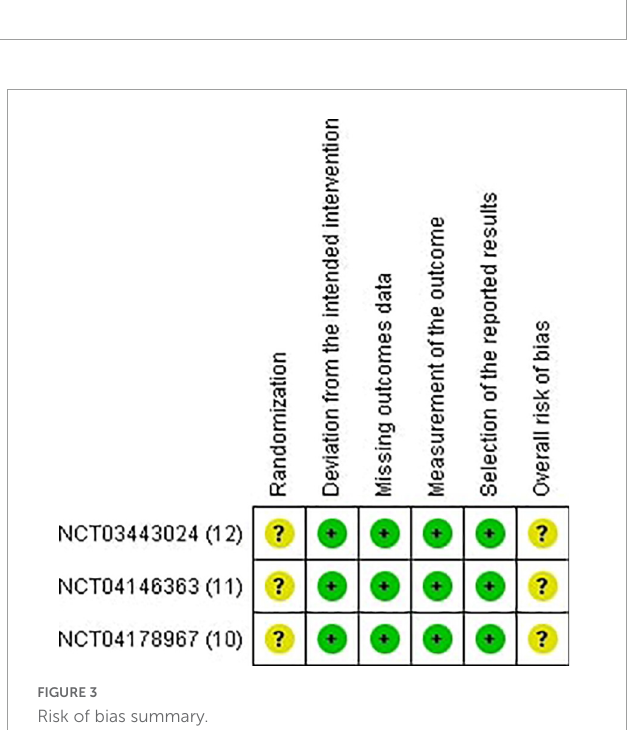
FIGURE3 Risk of bias